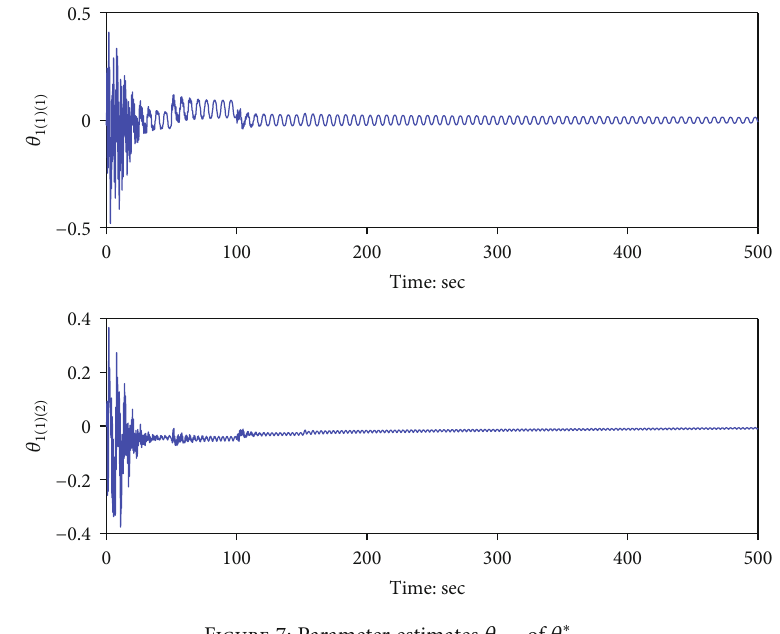
Figure 7: Parameter estimates θ